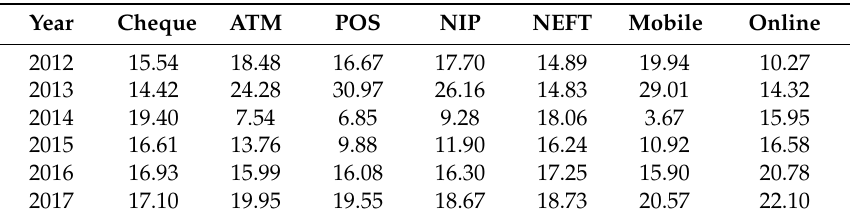
Table 1. Shares of E-Payment Technologies (in